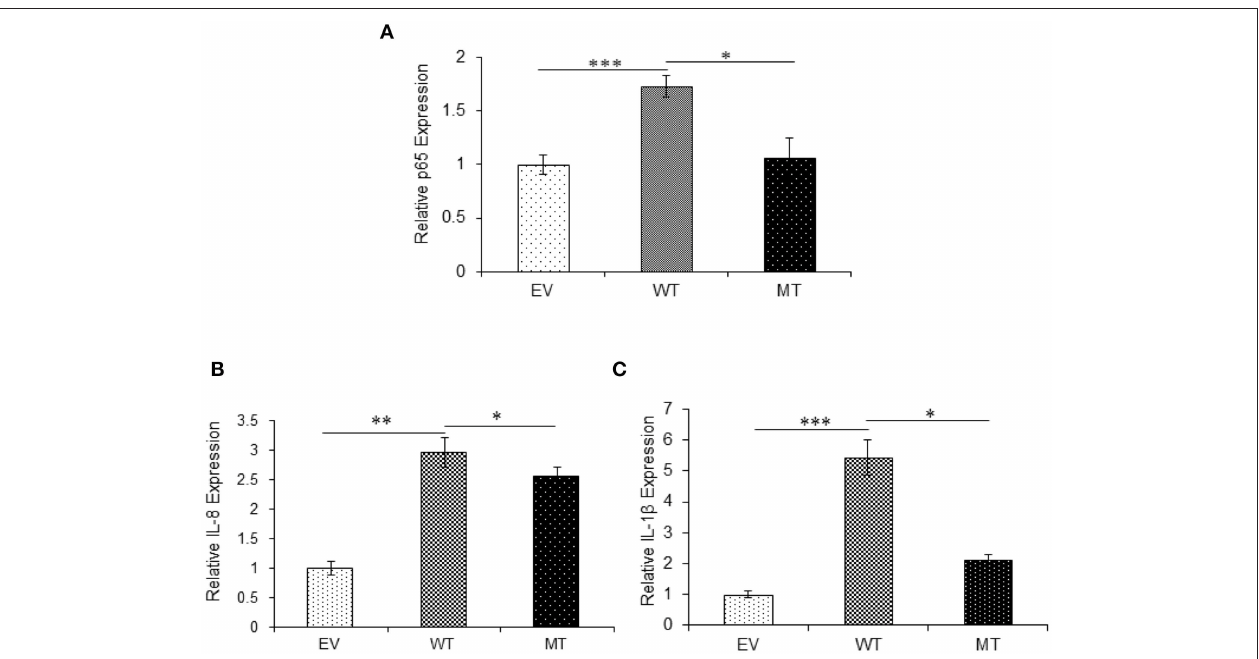
FIGURE 11 | IKK α absence results in higher pro-inflammatory response. p65 and its downstream pro-inflammatory cytokines showed significant higher expression in HT29 cells in the presence of miR-223 while a decrease in the presence of mutated form of miR-223. miR-223 and IKK α were co-transfected in HT29 cells for 48h and stimulated with 100ng/ml of LPS. After 6h of stimulation, RNA was isolated and reverse transcribed to investigate the mRNA expression of (A) p65, (B) IL-8, and (C) IL-1 β through qRT-PCR. GAPDH gene was used as an internal reference. P < 0.05 were statistically significant. Significance was estimated with respect to the pBABE-puro empty vector control group. * p ≤ 0.05, ** p ≤ 0.01, *** p ≤ 0.001. EV, empty vector; WT, wild type; MT, mutant. Bars represent standard error of the mean